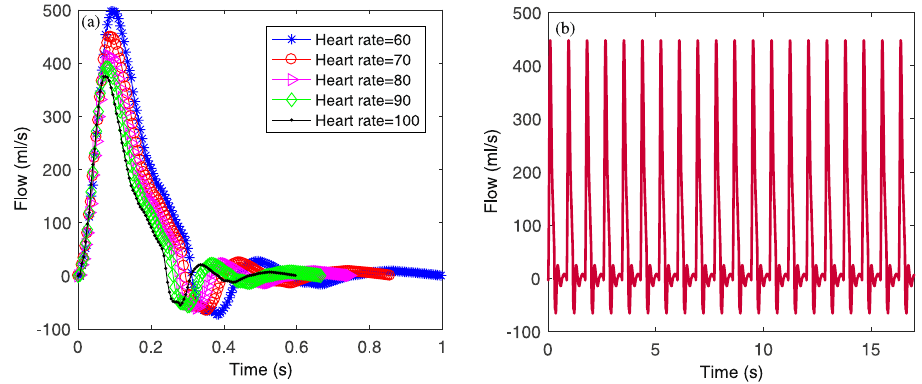
Figure 6. Input blood flow waveforms of model with ( a ) different heart rates and ( b ) a periodic flow waveform at heart rate 70 bpm fed to the TLM